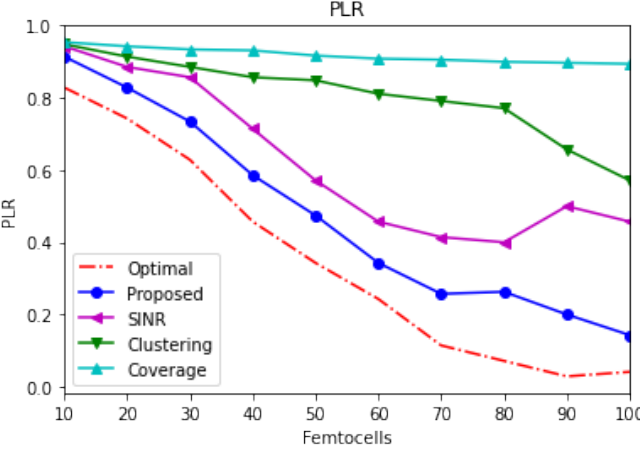
Figure 6. Macrocell average packet